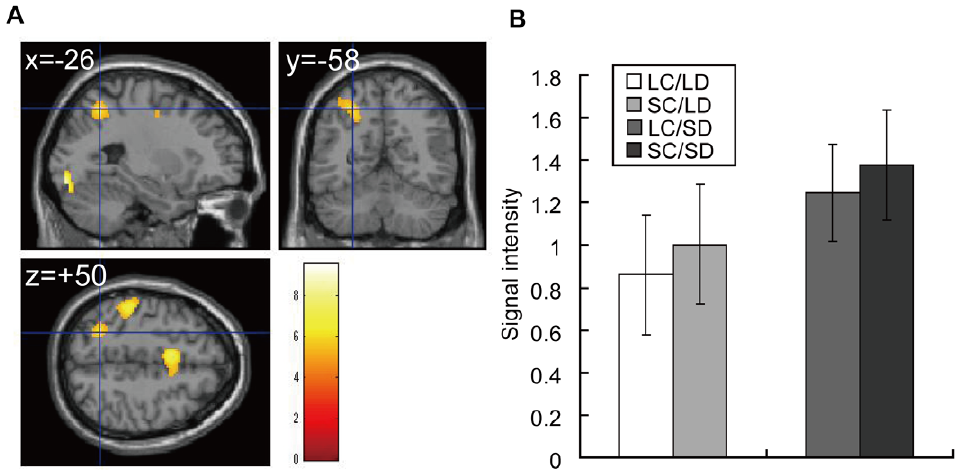
Figure 5. RT-related BOLD signal change. (A) Parametric contrast of regions activated in proportion to the measured RT of each condition (SC/ SD . SC/LD . LC/SD . LC/LD) ( p , 0.05, FWE corrected). The hair line indicates intra-parietal sulcus (IPS). (B) BOLD signal intensity at MNI coordinate ( 2 26, 2 58, 50).